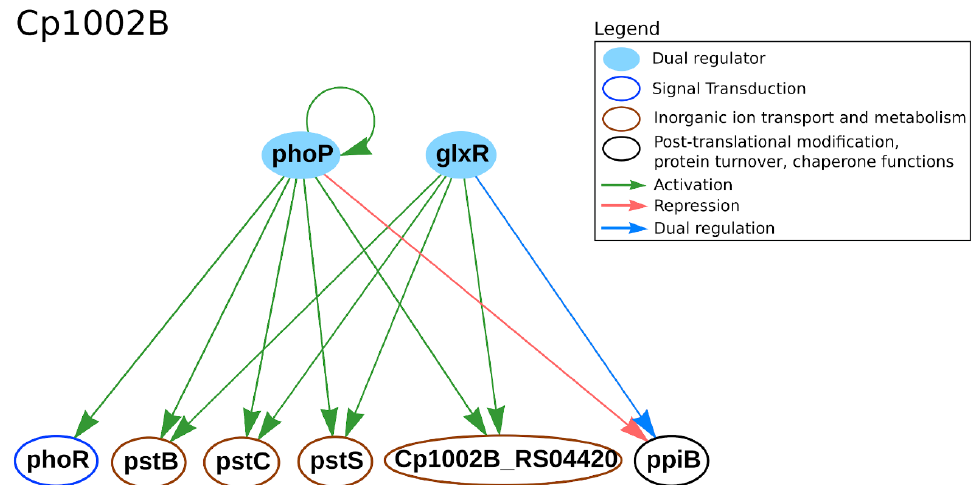
Figure 1. PhoPR transcriptional regulatory network (TRN) retrieved from CoryneRegNet 7 [22] for C. pseudotuberculosis 1002B. In the network, nodes represent the genes and arrows represent the regulatory interactions. The functional classification was performed using the database Eggnog (evolutionary genealogy of genes: non-supervised orthologous groups) [90].